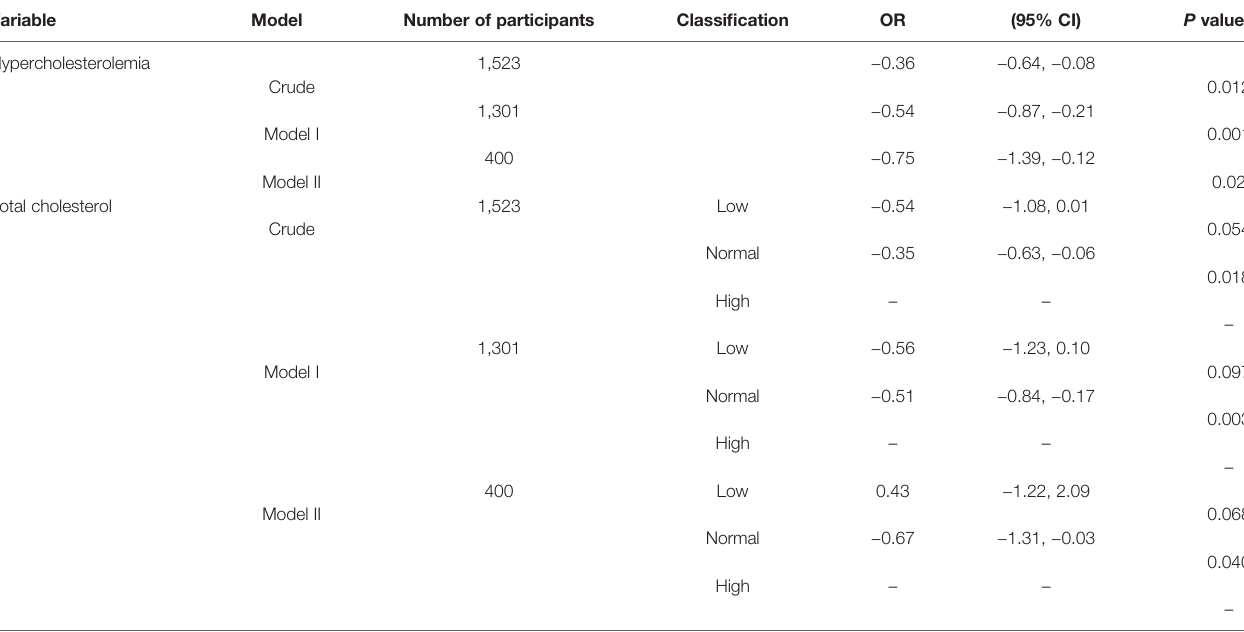
TABLE 3 | Multivariable logistic regression analysis evaluating the association between serum total cholesterol and risk of DTC.